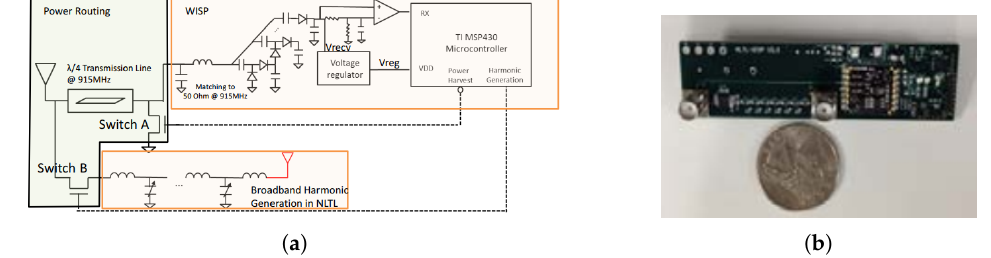
Figure 10. ( a ) Schematic block diagram of the harmonic RFID, and ( b ) implementation of the harmonic RFID circuit as in [25]. [Reproduced with permission from Y. Ma, A passive broadband harmonic RFID platform; published by IEEE, 2016].